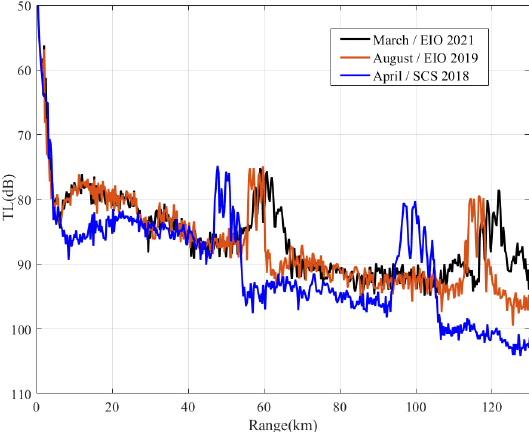
Figure 10. Comparison of numerical TLs at the depth of 255 m.